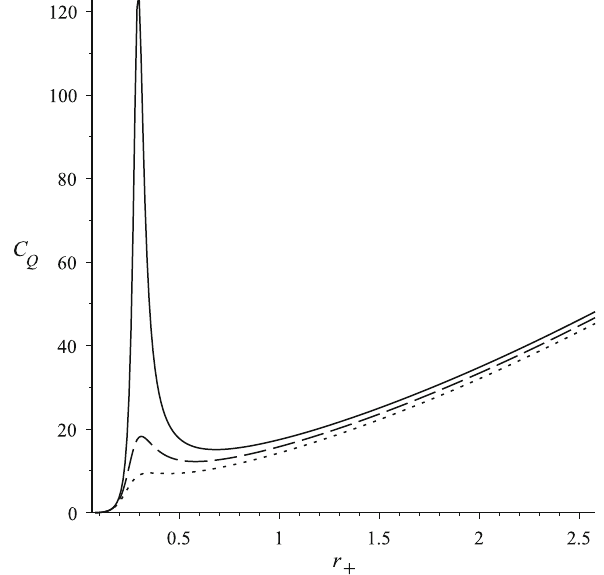
Fig. 5 Heat capacity C Q as a function of horizon radius r + when dis- continuitydisappears( n = 3, α = 0 . 5, b = 1, q = 0 . 1).Thesolidcurve corresponds to the value (cid:2) = − 7 . 4, the dashed curve corresponds to (cid:2) = − 8 . 5 and finally the dotted line is related to (cid:2) = − 10